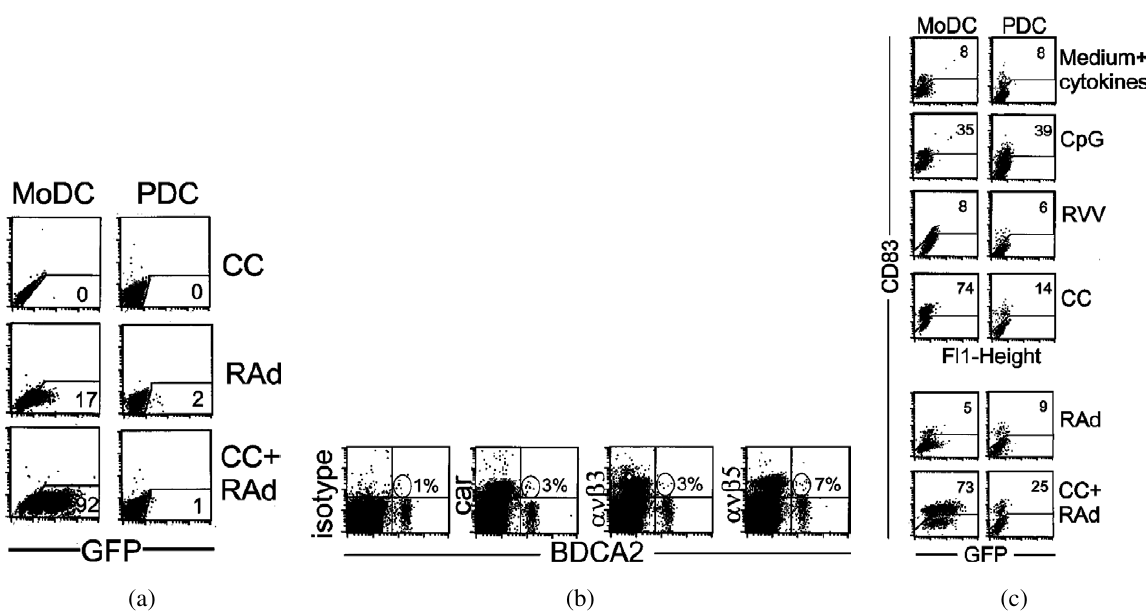
Fig. 1. (a) MoDC and PDC were incubated with the bi-specific chemical conjugate of anti-CD40 and anti-fiber knob mAb (CC) alone, RAd-GFP alone or the combination of CC and RAd-GFP. The numbers indicate the percentage of GFP positive cells. (b) Total PBMC were stained with BDCA2 in combination with antibodies directed against CAR, α v β 3 and α v β 5. The numbers indicate the proportion of BDCA2 positive cells that express these (co)-receptors (c) MoDC and PDC were incubated with medium, CpG2216, RVV, CC alone, RAd-GFP alone and CC and RAd-GFP combined. The numbers indicate the percentage of CD83 positive